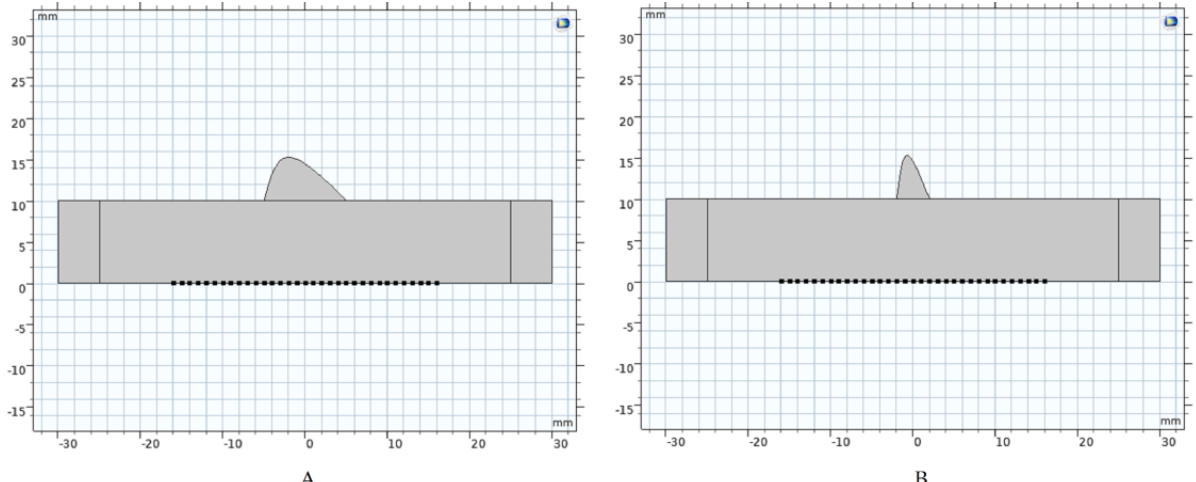
Figure 4. Two COMSOL ® domains with 32 array elements (back dots). Domain ( A ) and Domain ( B ). The rectangular area represents the muscle with PML at both left and right sides. The subdomain (in grey) over the rectangle represents the small lung part with inhomogeneity or “Lung disease zone” (LDZ).